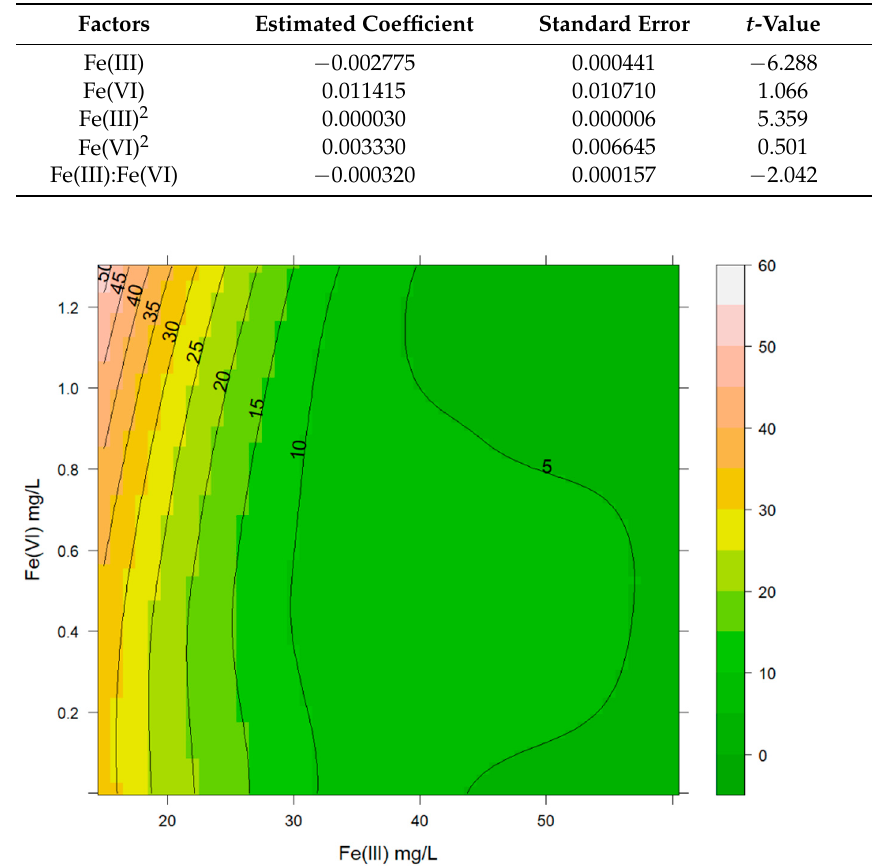
Figure 2. Local polynomial regression adjustment to assess the effects of Fe(III) and Fe(VI) on the final arsenic concentrations at the initial As(V) concentration of 1000 µg L − 1 . final arsenic concentrations at the initial As(V) concentration of 1000 µ g L